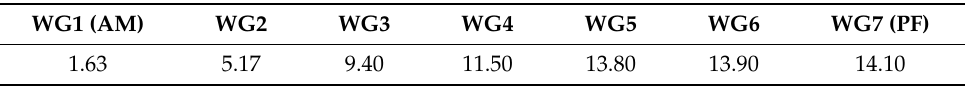
Table 1. Location of the wave gauges, as distance in m from the wavemaker (AM: amplitude matching; PF: phase